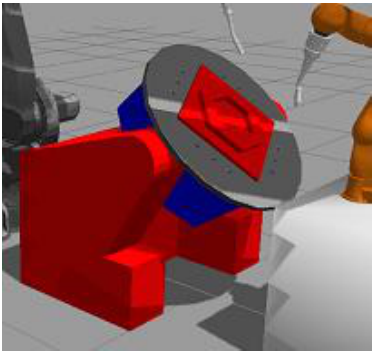
Figure 3. Turn and tilt table for welding in a gravity position.